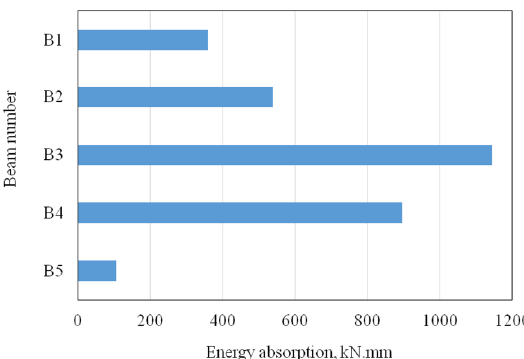
Fig. 7 Energy absorption for Group 1